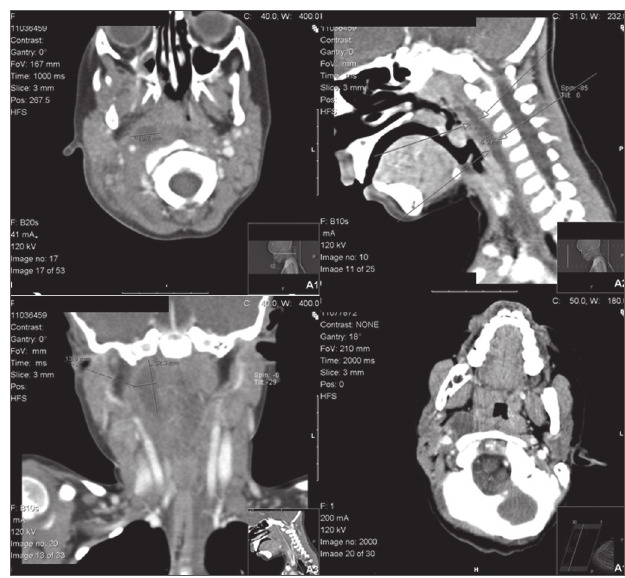
Figura 1. A. Abscesso retro e látero-faríngeo (TC, incidência axial). B. Abscesso retro e látero-faríngeo (TC, incidência sagital). C. Abscesso Látero-faríngeo (TC, incidências coronal). D. Abscesso látero-faríngeo (TC, incidência